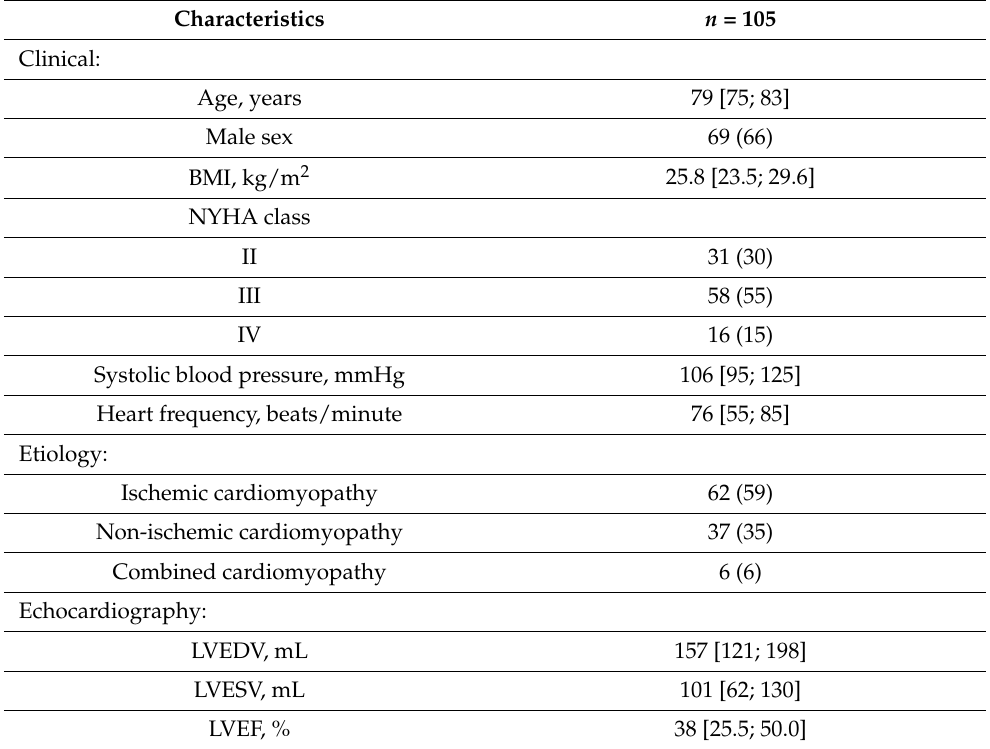
Table 1. Baseline characteristics of the studied population.